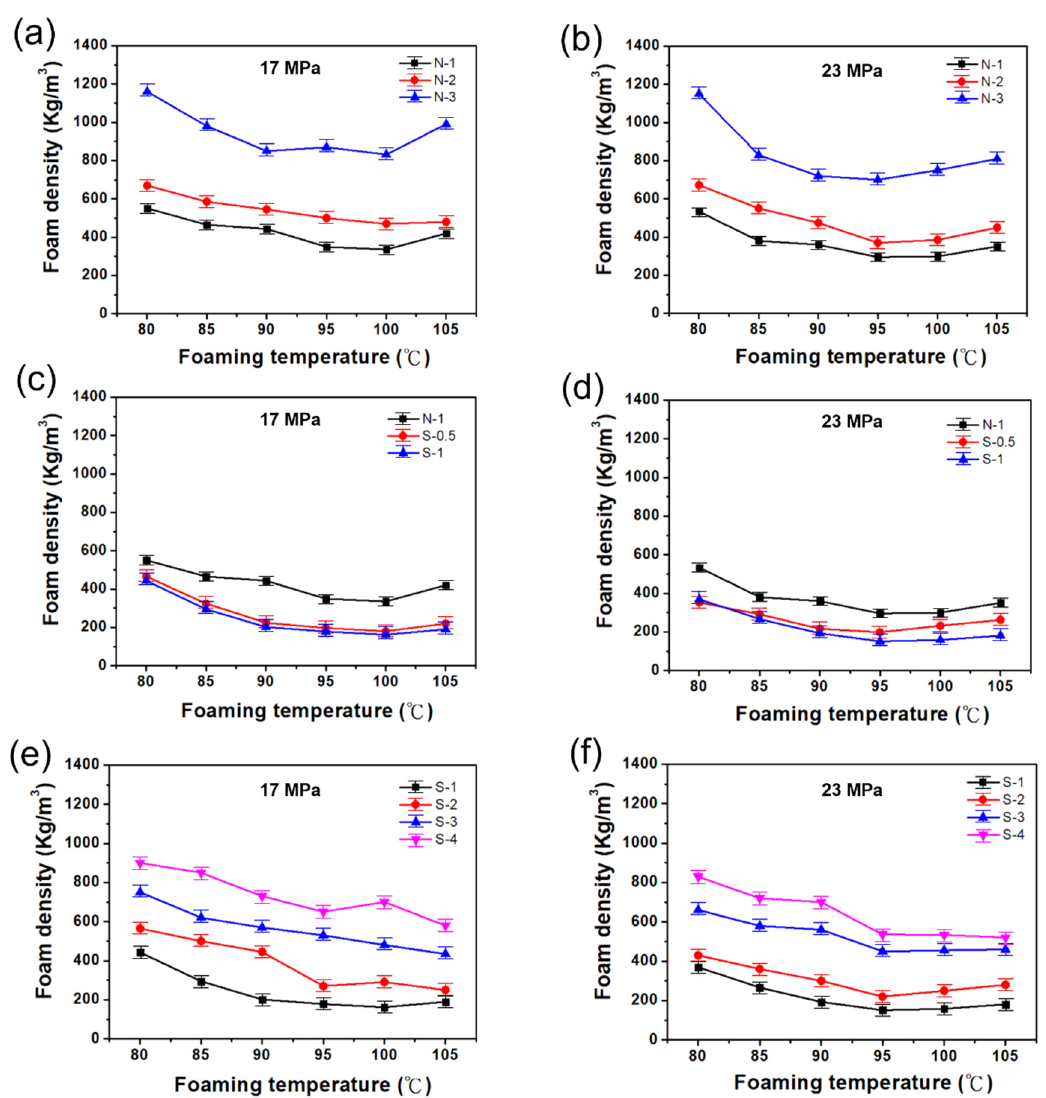
Figure 3. Dependence of TPS/PBAT and (TPS with SA)/PBAT composite foam density under six foaming temperatures and different foaming pressures. ( a , c , e ) Variation of composite foam density at 17 MPa. ( b , d , f ) Variation of composite foam density at 23 MPa.